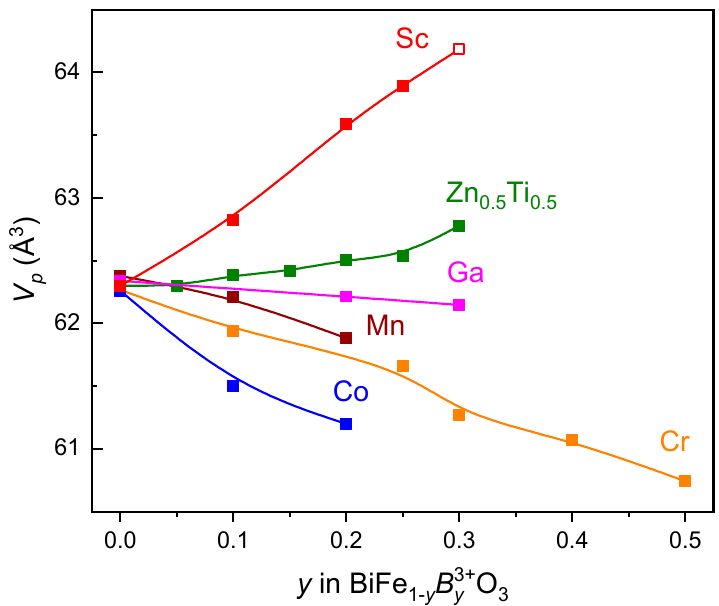
Figure 6. The compositional behaviour of the normalized unit-cell volume for the BiFe 1 − y B 3+ y O 3 perovskites with B 3+ = Ga [16], Co [14], Mn [11], Cr [20], Sc [19], and Zn 0.5 Ti 0.5 (this work). The data corresponding to the rhombohedral R 3 c phase range are only shown. The V p value of the BiFe 0.70 Sc 0.30 O 3 perovskite (open symbol) was determined by refinement of neutron diffraction data collected at room temperature on the annealed sample with the R 3 c symmetry (see Ref. [23] for details).